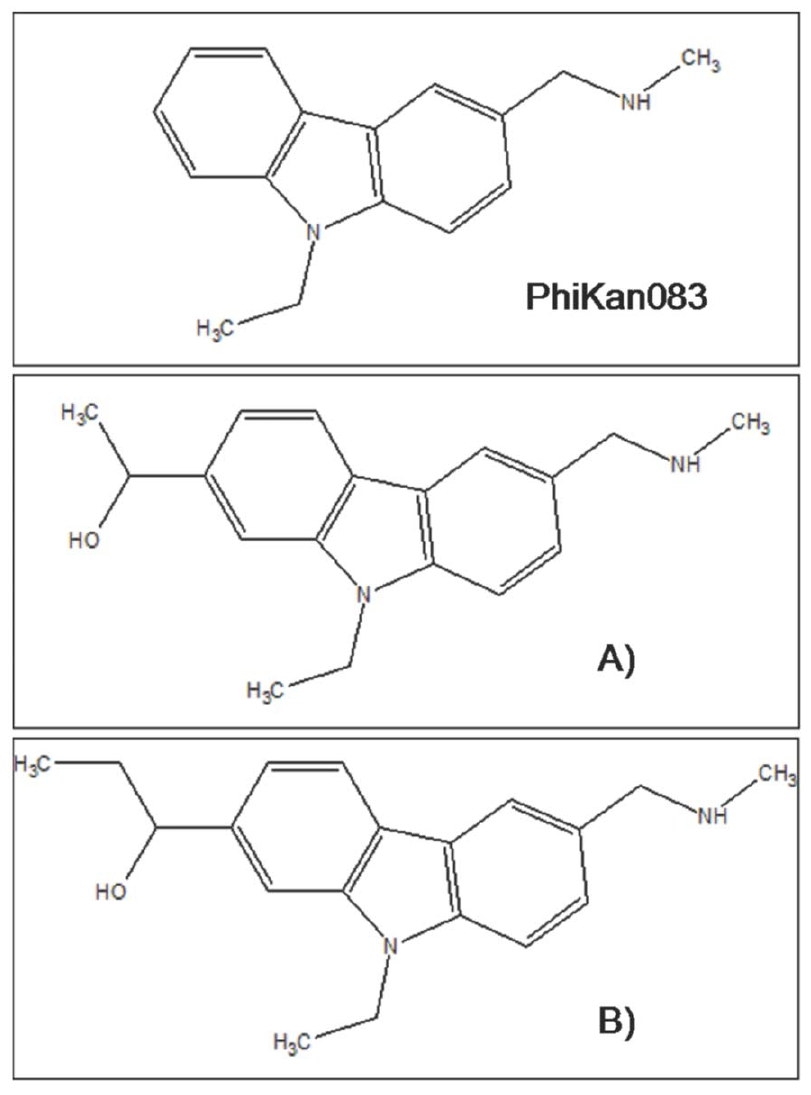
Figure 7. Molecular structure and of Phikan083 and modifications. The mean value we calculate for the binding free energy of the complex T-p53C-Y220C-PhiKan083 (2VUK) is , D G binding . = 2 29.42 kcal/mol (Standard deviation, STD=2.05 kcal/mol). A) First modification of Phikan083. , D G binding . = 2 29.80 kcal/mol (STD=2.71 kcal/mol). B) Second modification of Phikan083. , D G binding . = 2 35.33 kcal/mol (STD=2.81 kcal/mol).